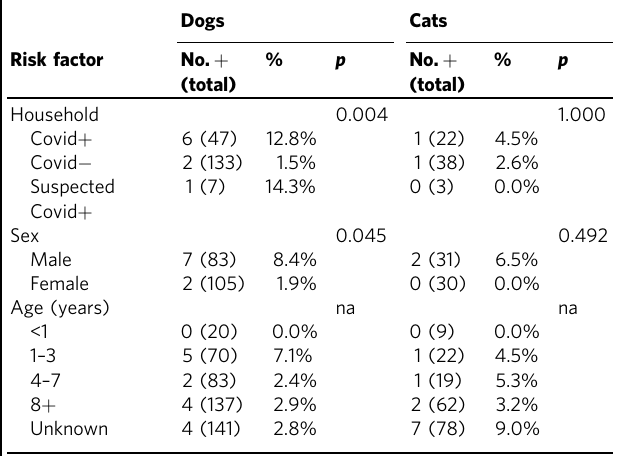
a For householdand sex, p -valuedetermined by two-sided Fisher ’ s exact test. Household COVID + de fi ned as one or more members of a household with a con fi rmed positive COVID-19 test. All the information was not available for all the animals. Both household ( p = 0.004) and sex ( p = 0.045) were associated with COVID seropositivity among dogs, whereas neither household ( p = 1.000) nor sex ( p = 0.492) were associated with COVID seropositivity among